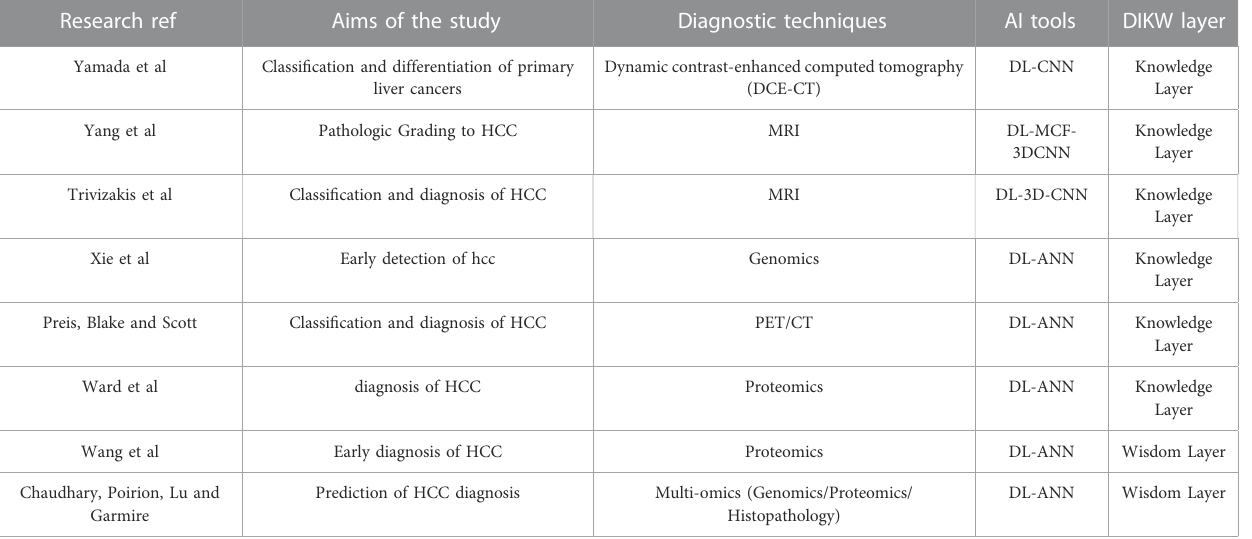
TABLE 3 Studies of Knowledge and Wisdom Layer in DIKW